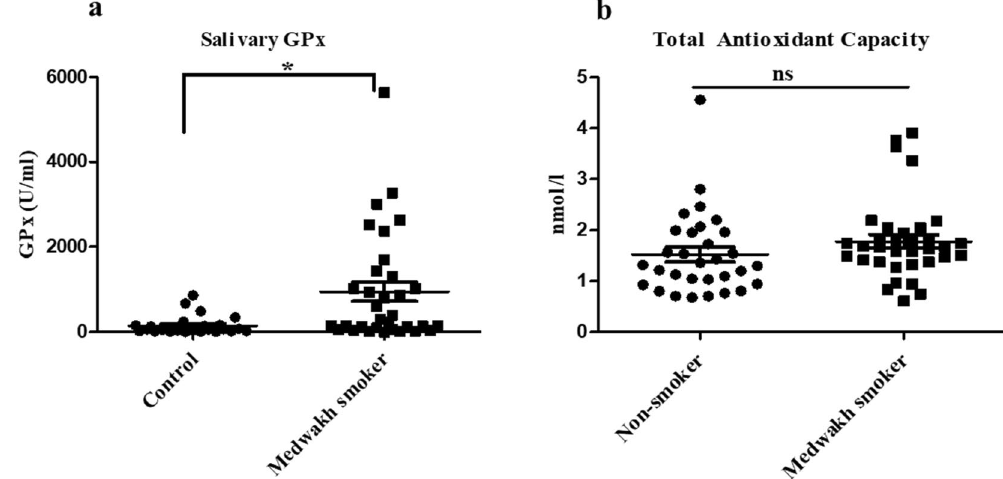
Figure 6. Salivary levels of ( a ) Glutathione peroxidase (GPx) and ( b ) Total Antioxidant Capacity (TAC) of saliva in medwakh smokers compared to non-smoking controls. Samples included 30 medwakh and 30 non- smoking controls. * p < 0.05 and ns-no significance by unpaired t-tests are indicated. Results are presented as mean ±